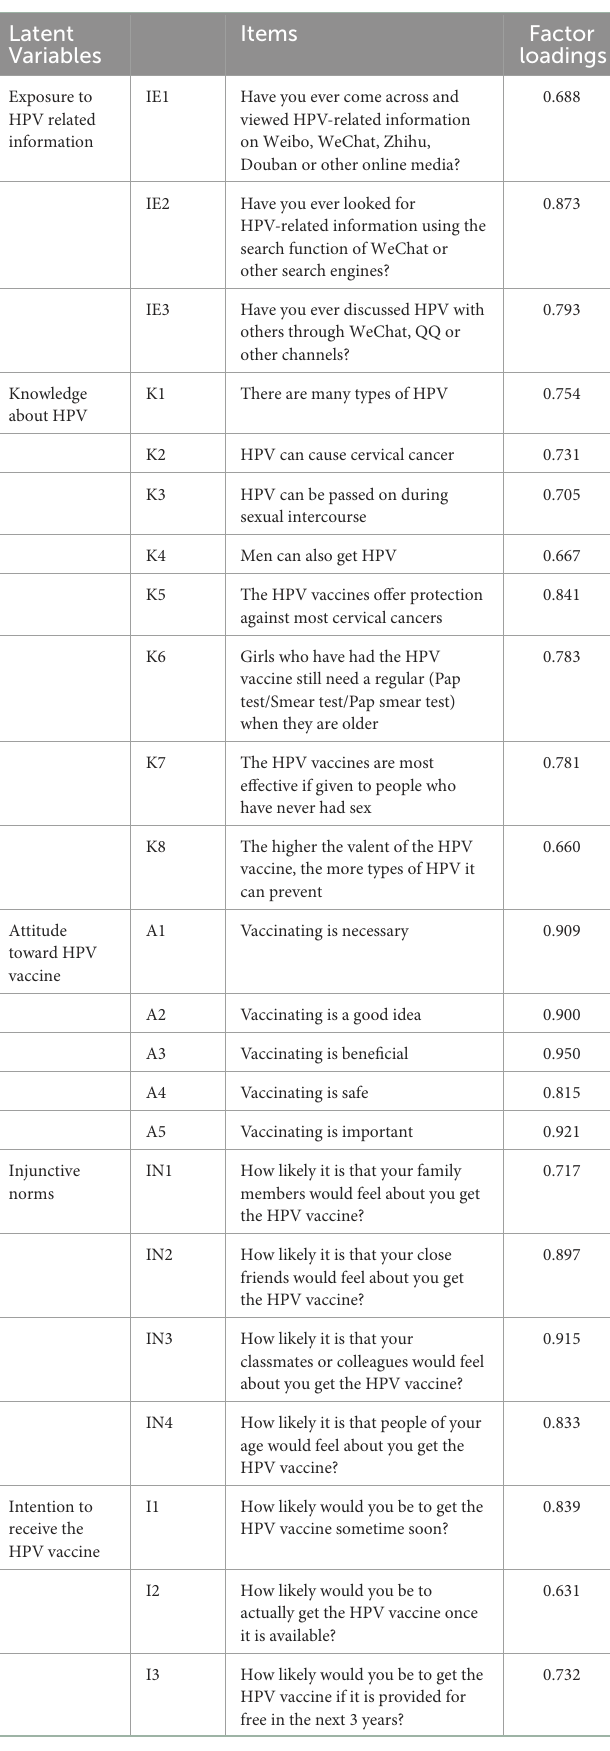
TABLE 3 Factor loadings. TABLE 4 Reliability and convergence validity testing